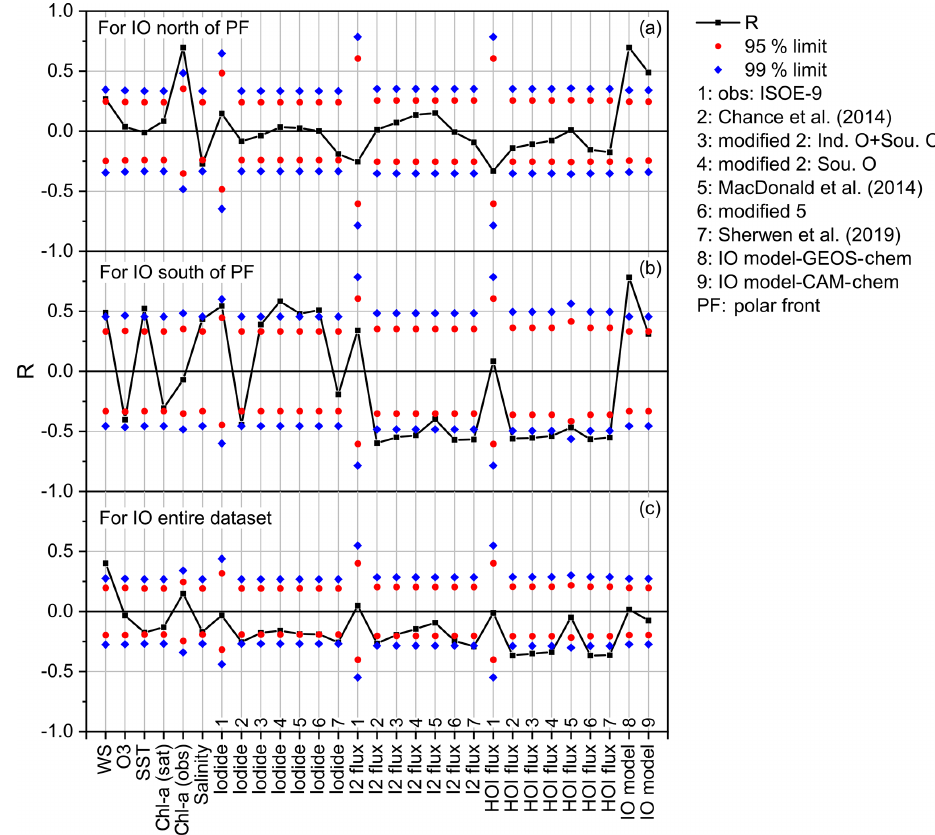
Figure 8. The Pearson’s correlation coefficient of observed iodine monoxide (IO) with oceanic and atmospheric parameters combined for the ISOE-8, IIOE-2, and ISOE-9 campaigns. Correlations are performed for daily averages of IO and corresponding parameters listed on the x axis. The black squares represent the Pearson’s correlation coefficients ( R ), the diamonds (blue) mark the 99% confidence limit, and the circles (red) correspond to the 95% confidence limits in all the panels. Panel (a) includes data from all campaigns to the north of the polar front (PF) ( n = 72), panel (b) represents combined data for the south of the polar front ( n = 48), and panel (c) includes the entire dataset from three campaigns ( n =